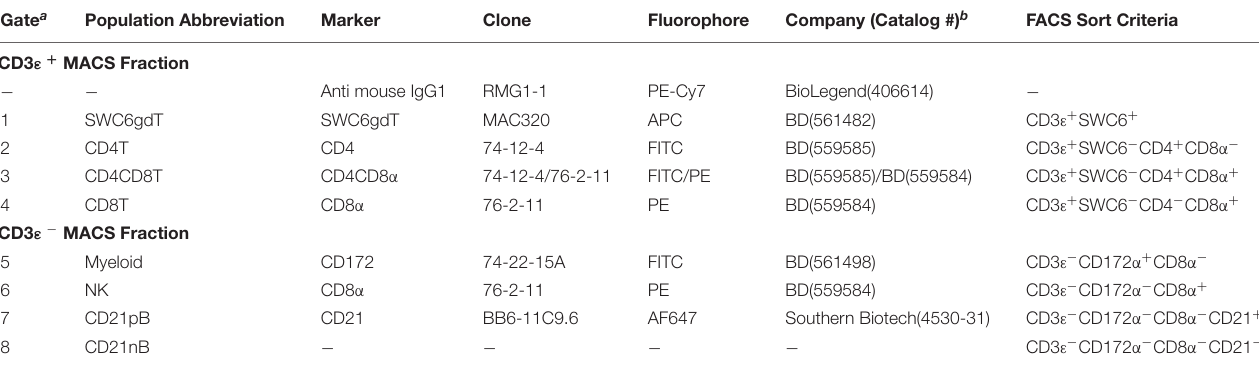
TABLE 1 | Abbreviations and phenotype information of pig sorted immune